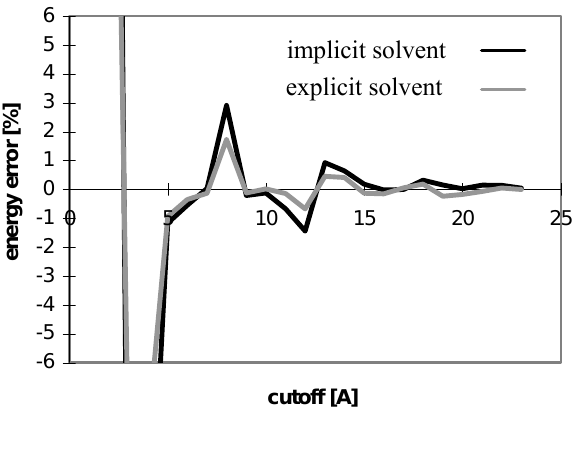
Figure 13. Dependency of energy error on cutoff for nucleotide-sugar N3 in explicit